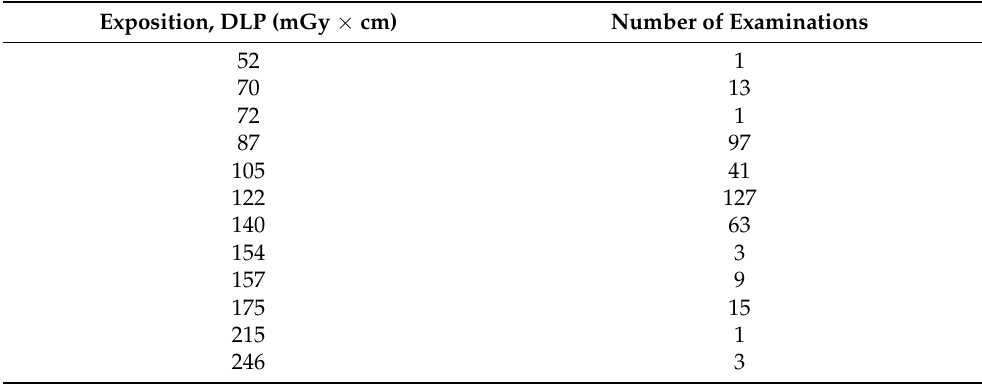
Table 2. Frequency of radiation exposition for CBCT